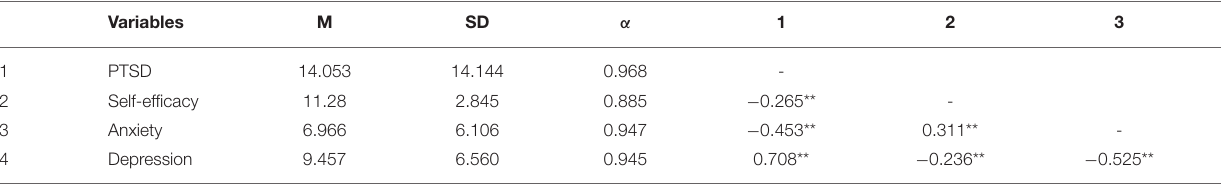
TABLE 4 | The means, SD, and internal consistencies of variables.